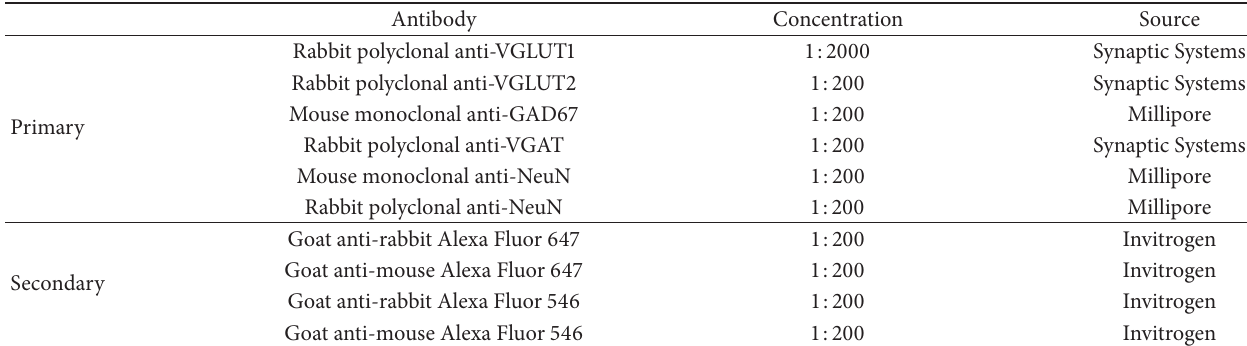
Table 1: Antibodies